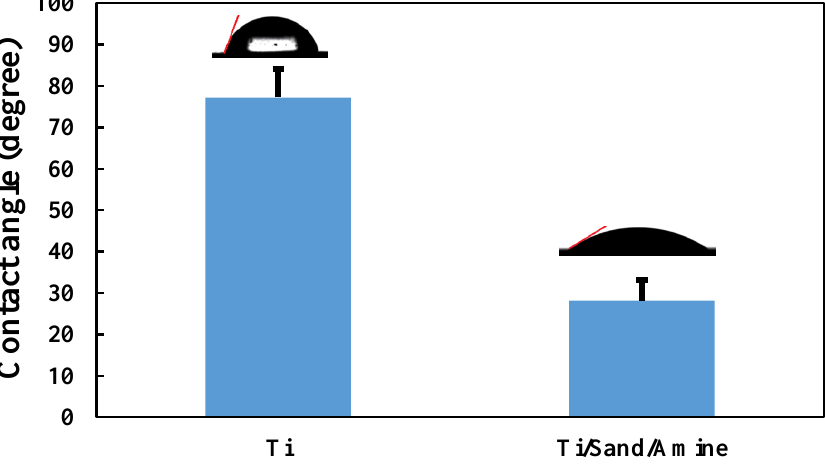
Figure 6. Contact angles of the untreated titanium surface and titanium surface treated with amine plasma-polymerization.